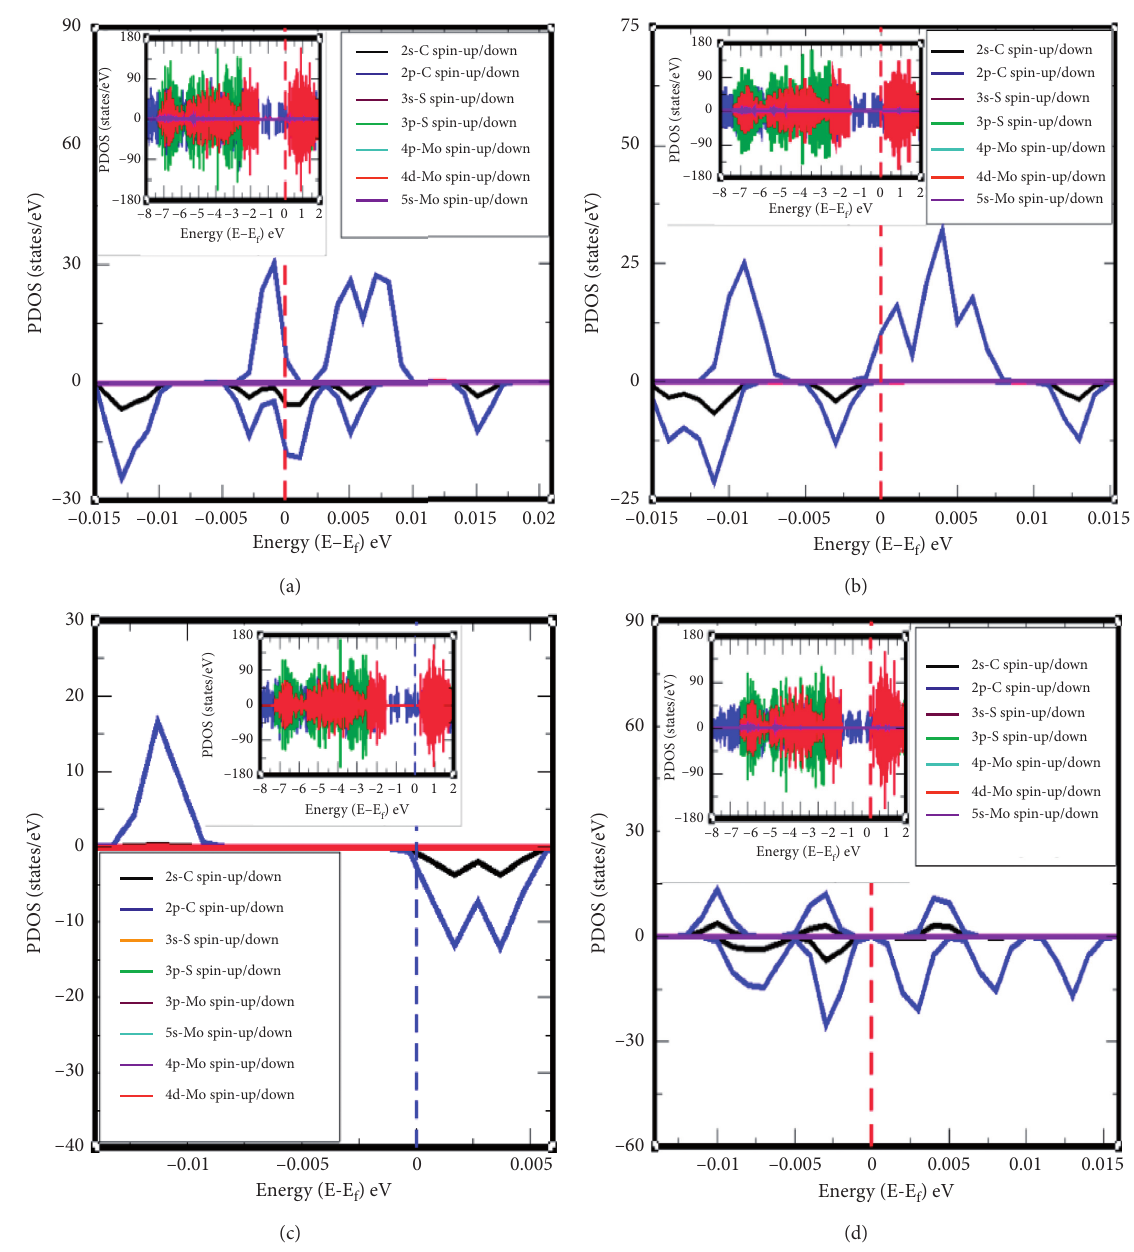
Figure 6: (a) PDOS plot of individual spin-up and spin-down electrons orbital of all atoms in R-1C atom vacancy defects in HS-G/MoS PDOS plot of individual spin-up and spin-down electrons orbital of all atoms in L-1C atom vacancy defects in HS-G/MoS 2 . (c) PDOS plot of individual spin-up and spin-down electrons orbital of all atoms in C-1C atom vacancy defects in HS-G/MoS 2 . (d) PDOS plot of individual spin-up and spin-down electrons orbital of all atoms in 2C atom vacancy defects in HS-G/MoS 2 , where the states above the horizontal line represent spin-up electrons and a state below the horizontal line represents spin-down